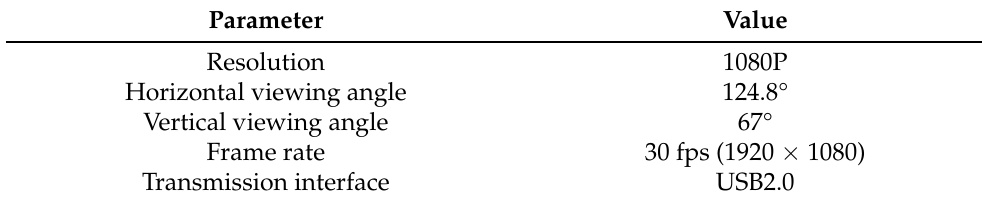
Table 3. Parameters of a wide-angle camera.